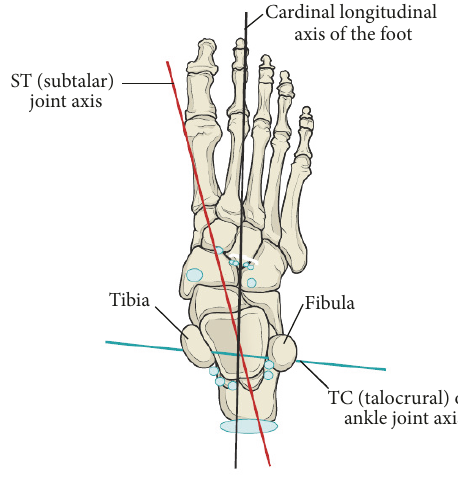
Figure 5: Human foot axes of rotation [45].